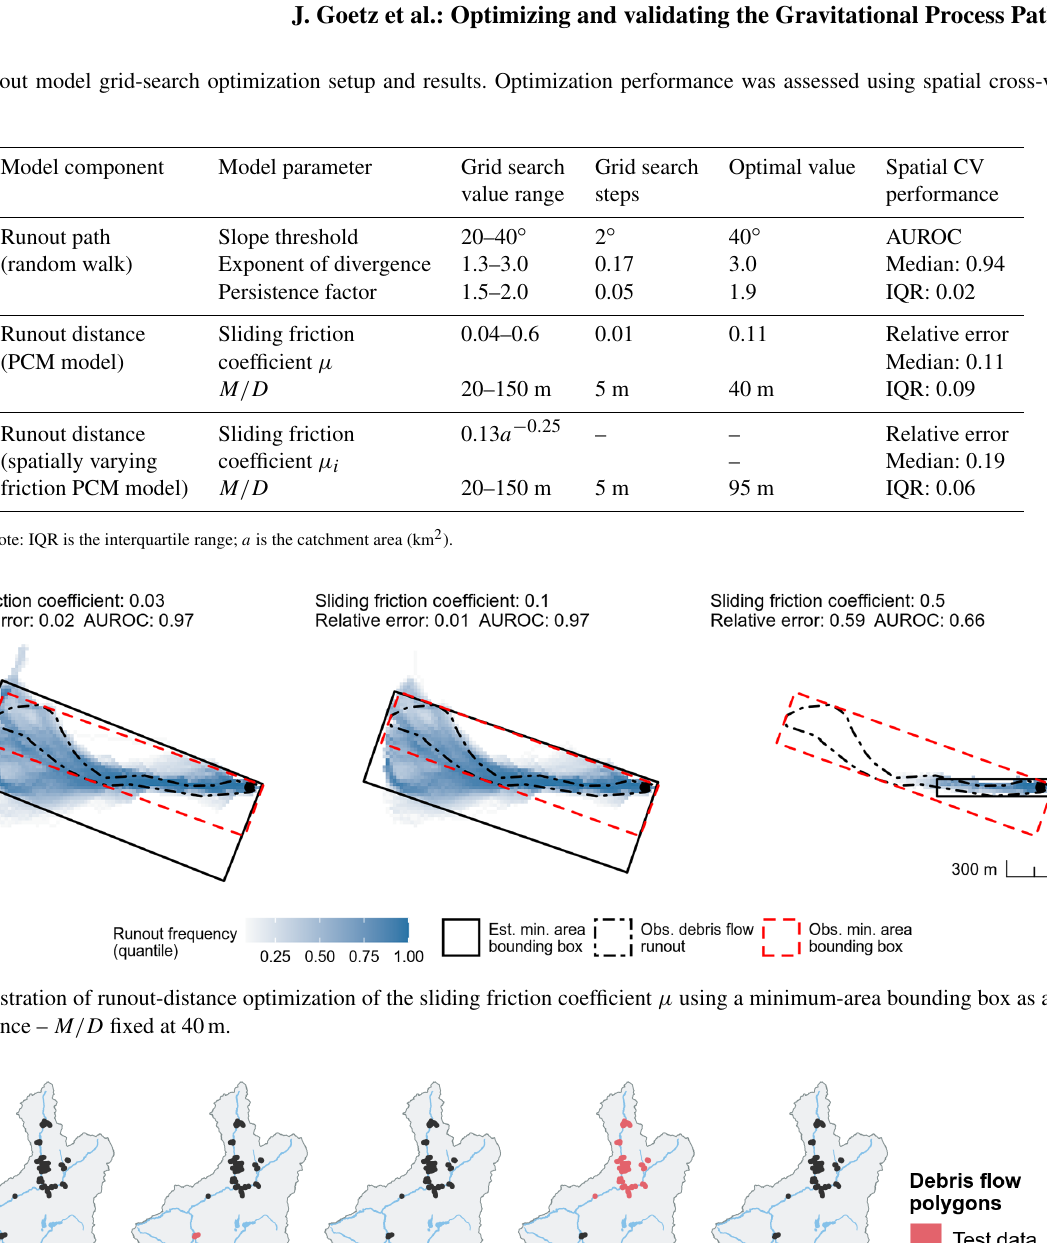
higher degree of transferability, thus being considered more reliable for application to the entire study